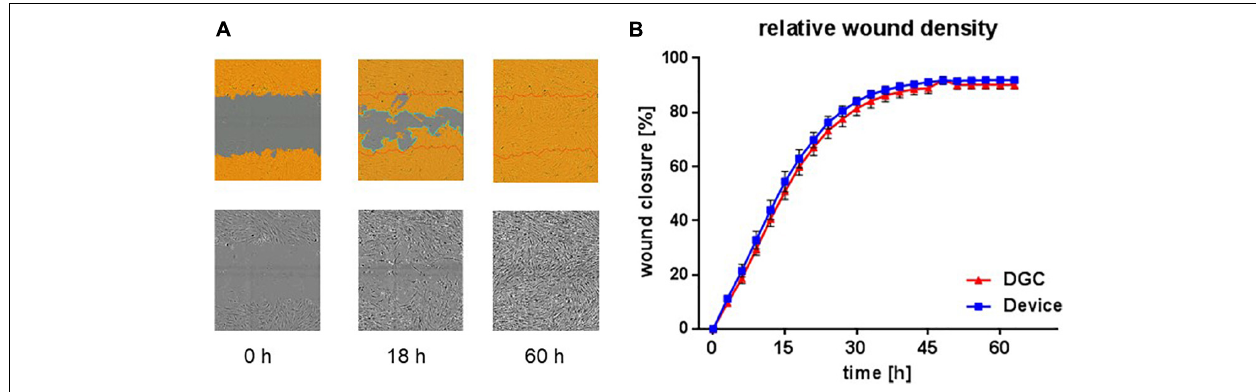
FIGURE 7 | In vitro wound healing potential. Scratch assay to assess in vitro migration and proliferation, i.e., “wound healing” potential at P3. Exemplary microphotographs from life cell imaging show scratch “wound” in P3 MSC monolayer at start (0 h), proceeding (18 h), and complete closure (60 h) in% (A) . Images captured with 10 × objective in the IncuCyte ZOOM system. Quantification of relative wound density over time (B) . Each data point represents means of biological replicates ( n = 4–5 donors). Error bars: SEM. Two-way ANOVA.